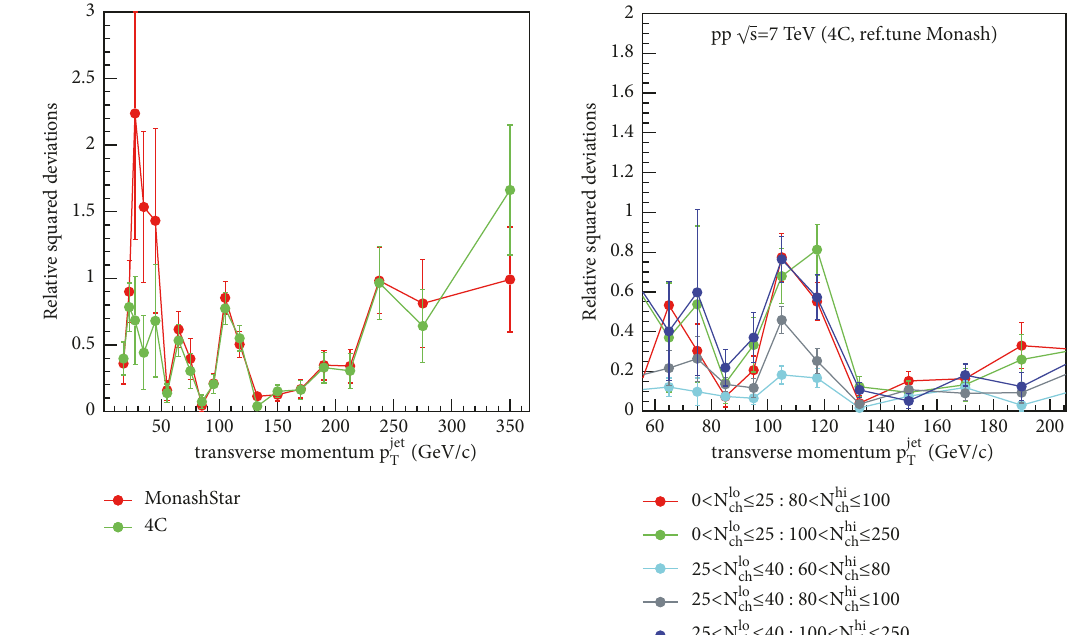
Figure 11: Left: square sum of the bins in the 𝐷𝑅(𝑟) − 1 diagram for the 4C (green) and Monash ∗ (red) tunes with respect to the Monash ≤ 25 as low-multiplicity, and 80 < 𝑁 ≤ 100 as high-multiplicity selections. Right: square , for 0 < 𝑁 reference tune, depending on the 𝑝 jet ch ch T , for various low- sum of the bins in the 𝐷𝑅(𝑟) − 1 diagram for the 4C tunes with respect to the Monash reference tune, depending on the 𝑝 jet T and high-multiplicity selections, as listed in the legend. (The 𝑝 jet range is restricted to omit parts with large fluctuations.) T